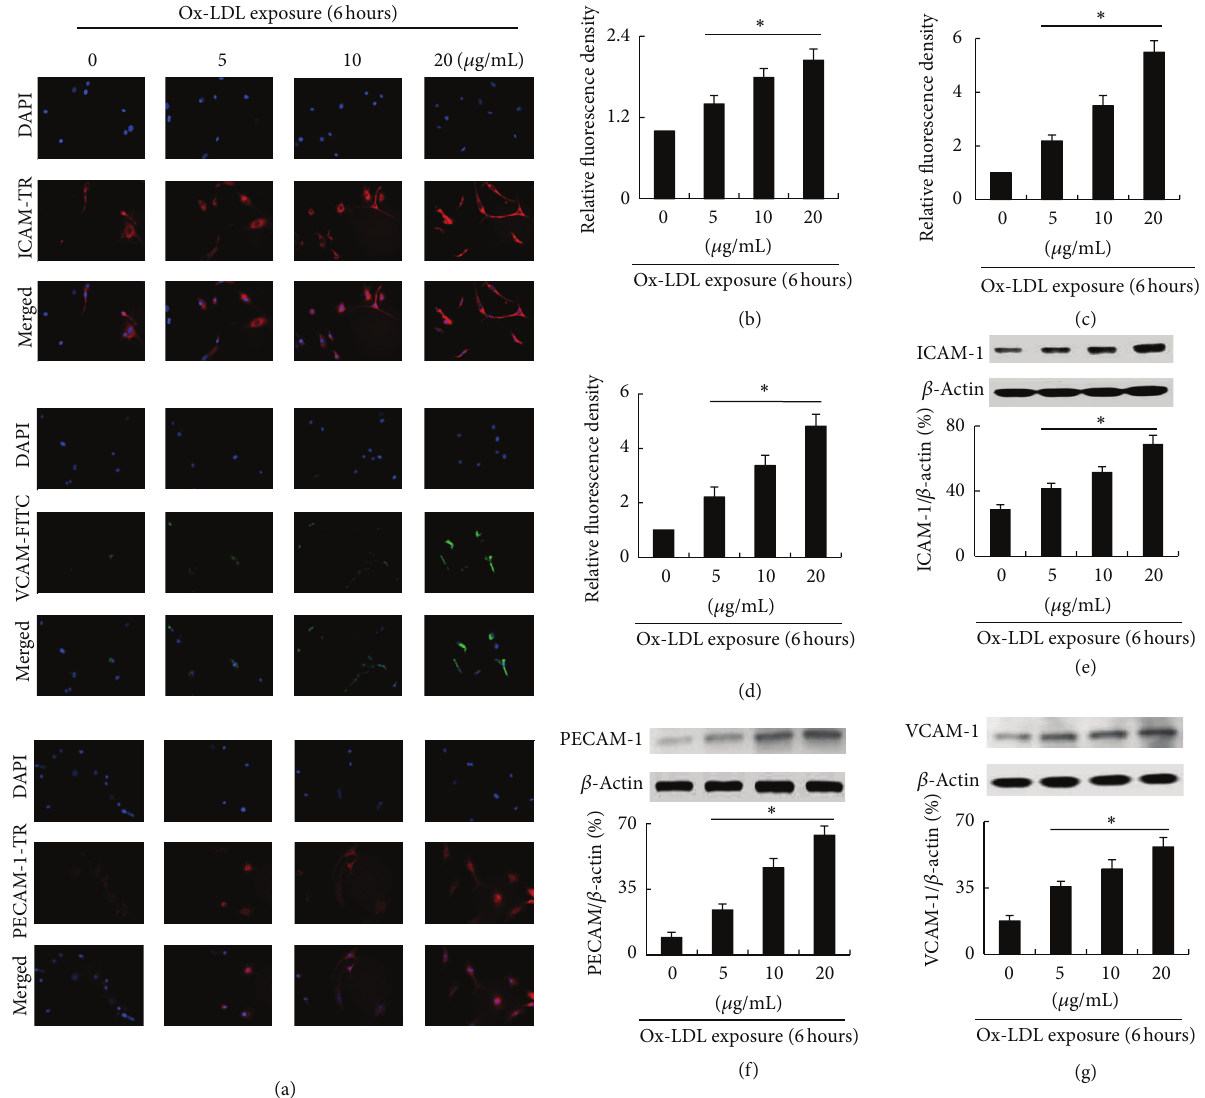
Figure 3: Ox-LDL increases expression of ICAM-1, PECAM-1, and VCAM-1 in a dose-dependent manner in bmMSCs. (a) Immunofluores- cence assay shows expression of ICAM-1, PECAM-1 and VACM-1 in bmMSCs exposed to 0, 5, 10 and 20 𝜇 g/mL ox-LDL for 6 hour; (b)–(d) Relative fluorescence density of ICAM-1, PECAM-1, and VCAM-1; (e)–(g) Western-blotting assay shows expression of ICAM-1, PECAM-1, and VCAM-1 in bmMSCs exposed to 0, 5, 10, and 20 𝜇 g/mL ox-LDL for 6 hours. Bar graphs represent mean ± SD ( 𝑛 = 4 per group). ∗ 𝑃 < 0.01 versus